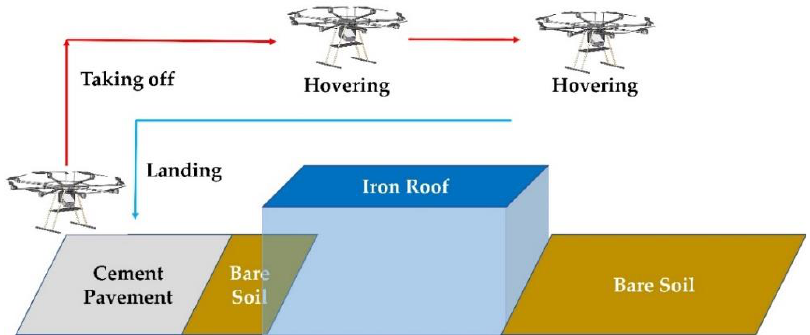
Figure 12. Schematic diagram of the flight path.